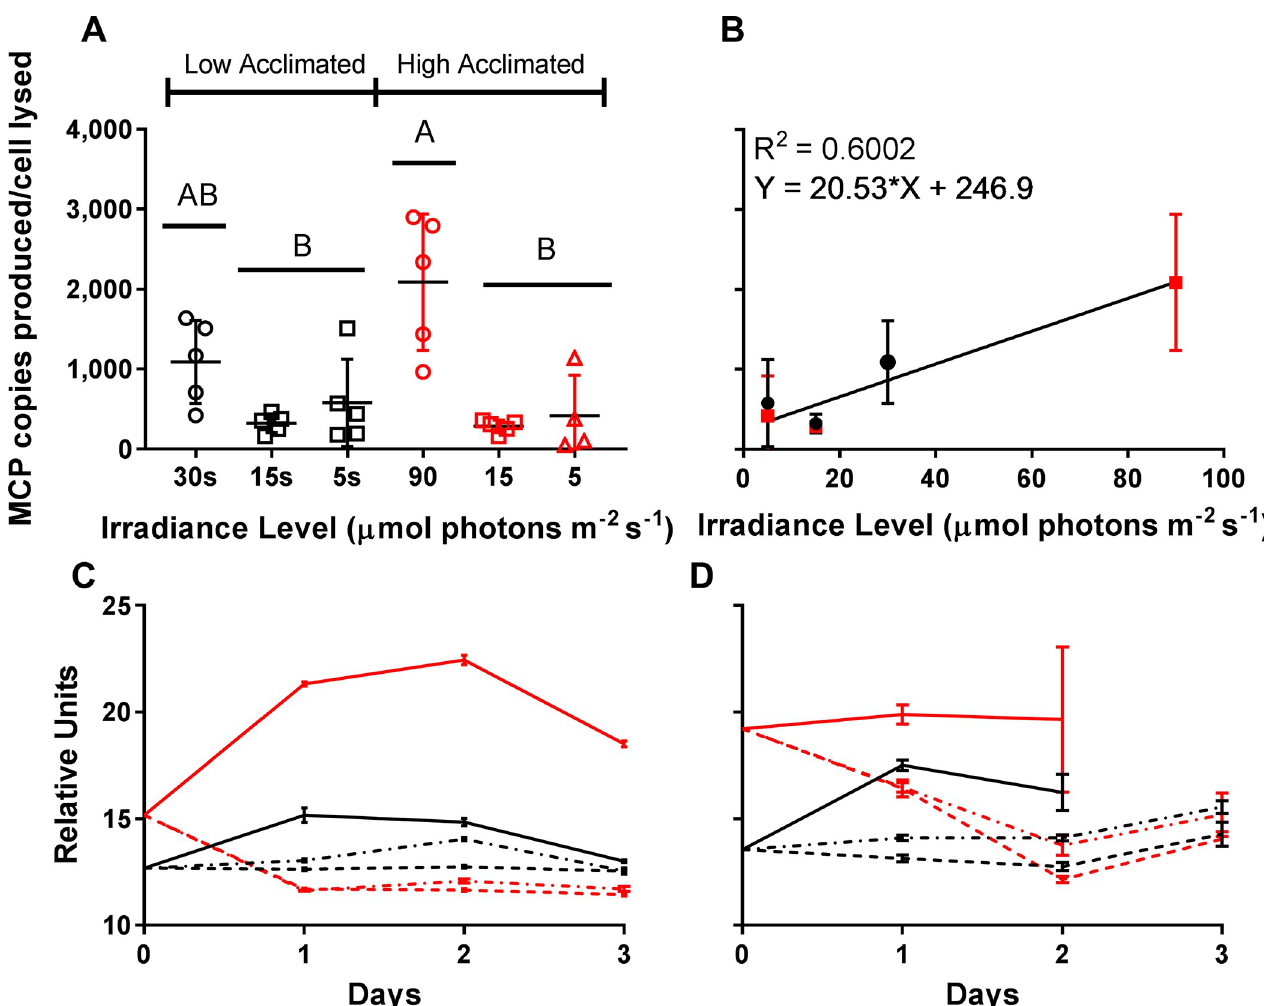
Fig 4. Effects of reducing light levels to 15 and 5 μ mol photons m -2 s -1 after infection on Burst Size (Fig 3). Red Lines and symbols are high irradiance acclimated (90 μ mol photons m -2 s -1 ), while black lines are low irradiance acclimated (30 μ mol photons m -2 s -1 ). A) MCP copies produced per cell lysed for each treatment. Letters represent statistically indistinguishable burst sizes (one-way ANOVA; see Methods and S2 Table). B) Burst Size v. Irradiance Level during the infection. C) Mean forward scatter of uninfected A . anophagefferens cultures over the first three days of the 5-day experiment (Fig 2C, Fig 2D) as determined by flow cytometry. D) Mean forward scatter of infected A . anophagefferens cultures over the course of the 5-day experiment (Fig 2C, Fig 2D) as determined by flow cytometry. Plotted are only populations > 10,000 cells/mL. Solid lines indicate acclimated cultures maintained at acclimated irradiance levels after infection, dotted and dashed lines indicate acclimated cultures transferred into 15 μ mol photons m -2 s -1 light after infection, and dashed lines indicate acclimated cultures transferred into 5 μ mol photons m -2 s -1 light after infection. Error is plotted as standard deviation.